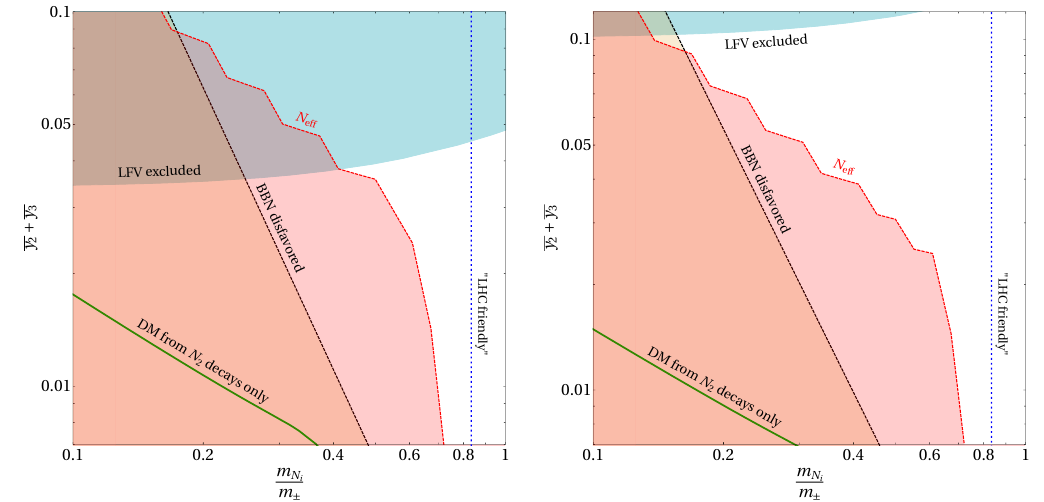
Figure 4 . BBN constraints for the case where N 2 dominantly decays into electrons and muons (left panel) and tau-leptons (right panel) are disfavoring parameter space below the black lines. The regions excluded by a conservative N e(cid:11) limit are shown in red. The solid green curve indicates the parameter space for a limiting case in which all of the DM is produced by N 2 decays. The regions in blue represent constraints from LFV experiments. Finally, the region to the left of the vertical blue dashed line is collider friendly in the sense that the mass gap between (cid:27) (cid:6) and N 2 ; 3 is su(cid:14)ciently large. The value of the charged scalar mass in both panels is (cid:12)xed to m 600 GeV. On the y-axis we show the average Yukawa coupling of N 2 and N 3 , de(cid:12)ned as (cid:22) y 2 + (cid:22) y 3 2 + 2 (1 = 3) ( y 2 (cid:11) y 3 (cid:11) (cid:11) j j j j p P